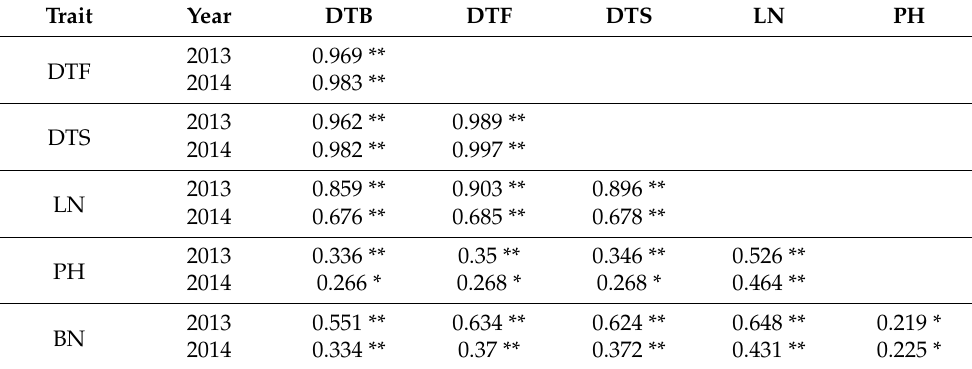
Table 2. Correlation between the traits examined in 2013 and 2014 (DTB—the number of days from sowing to bolting; DTF—the number of days from sowing to flowering of the first flower; DTS—the number of days from sowing to seed setting of the first flower, LN—total number of leaves; PH—plant height when the first flower fully opened; and BN—total number of branches of main inflorescence of Lactuca sativa L. cv. Chimasanchu (P1), Lactuca sativa L. cv. Banchu Red Fire (P2), and F5 RIL population * and ** indicate significance at p < 0.05 and p < 0.01, respectively. Trait Year DTB DTF DTS LN